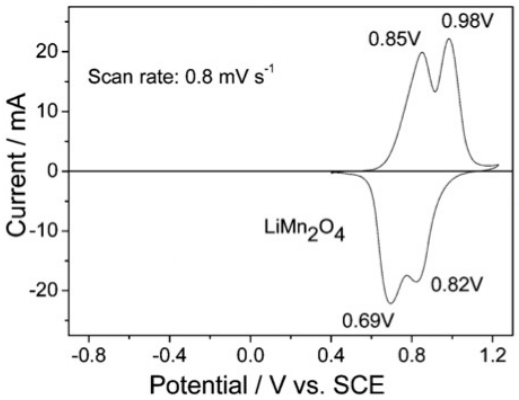
Figure 3. CV curve of the micrometer LiMn 2 O 4 in the saturated Li 2 SO 4 solution (modified from Ref. [41] with permission from Wiley).